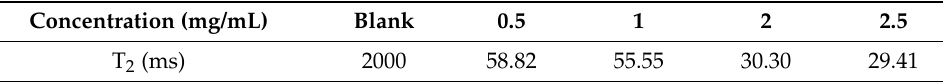
Table 2. T 2 signal values obtained from curve